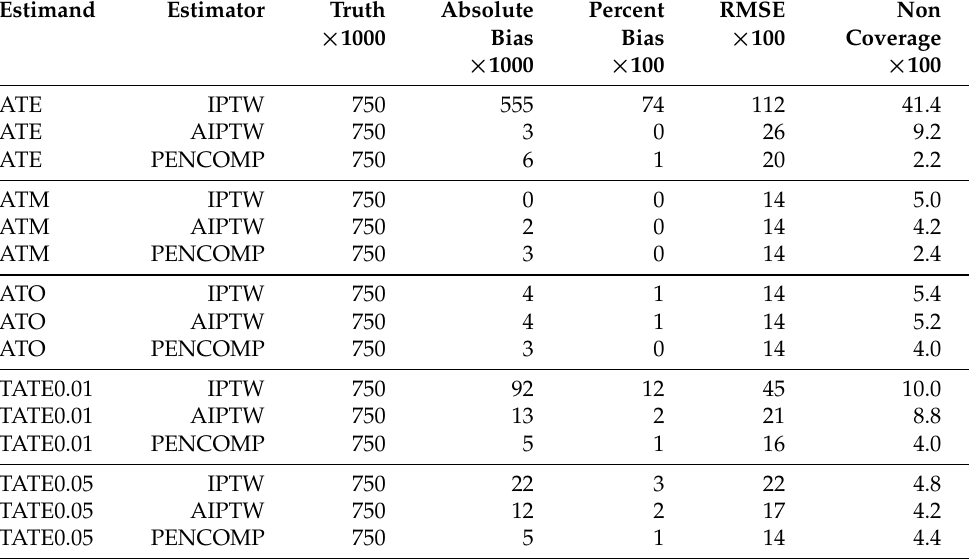
Table 1. Empirical bias (in absolute and percentage), RMSE, and 95% CI (non) coverage, across the methods in a linear and continuous outcome model for the scenario where both the propensity score model and the outcome model were correctly specified. Results were based on 500 simulations with sample size of 500; 500 bootstraps were used to estimate standard errors for the weighted estimators and 200 complete datasets for PENCOMP. ATE = Average treatment effect; ATM = average treatment effect on an evenly matchable set; ATO = average treatment effect on the overlap population; TATE α = truncated average treatment effect with a truncation at a pre-defined α